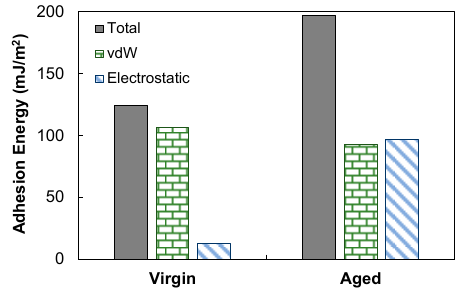
Figure 9. Total adhesion energies at the asphalt–calcite interface and the components.